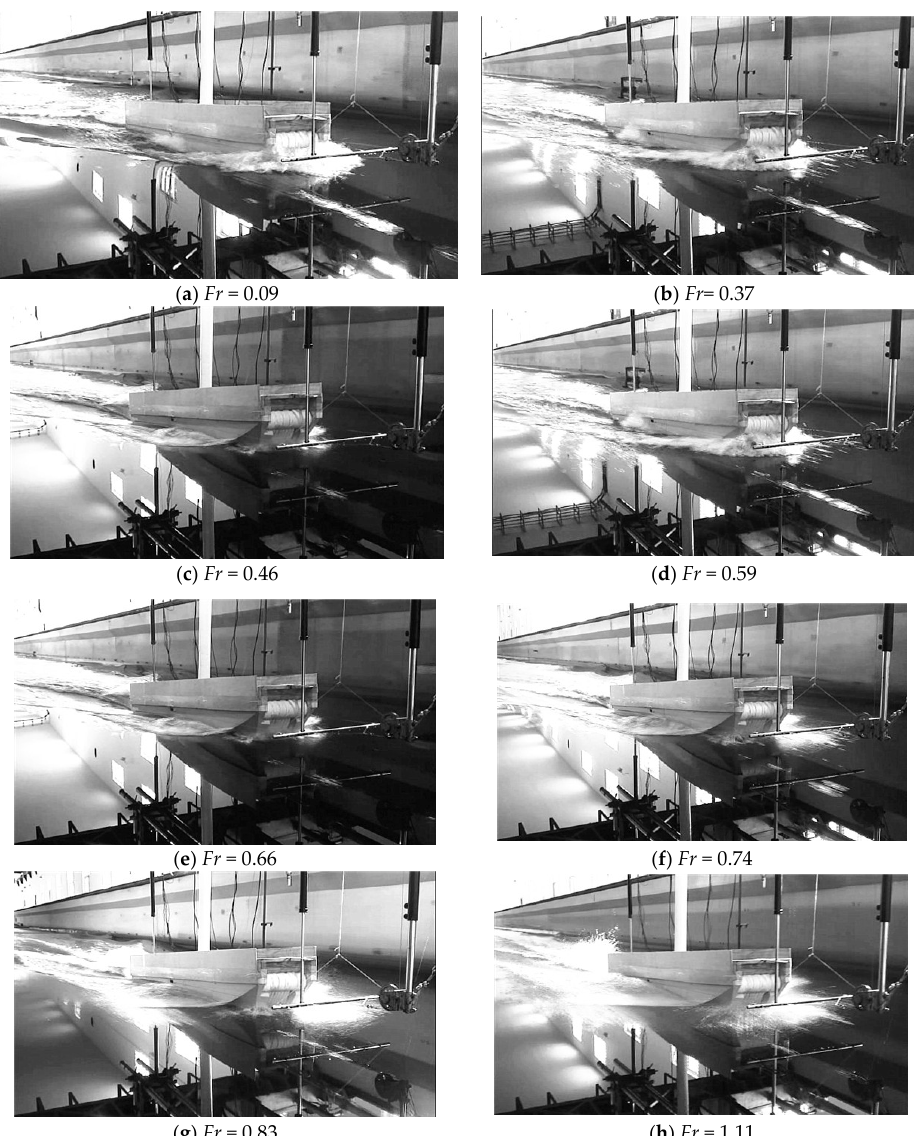
Figure 12. Resistance components Comparison under condition